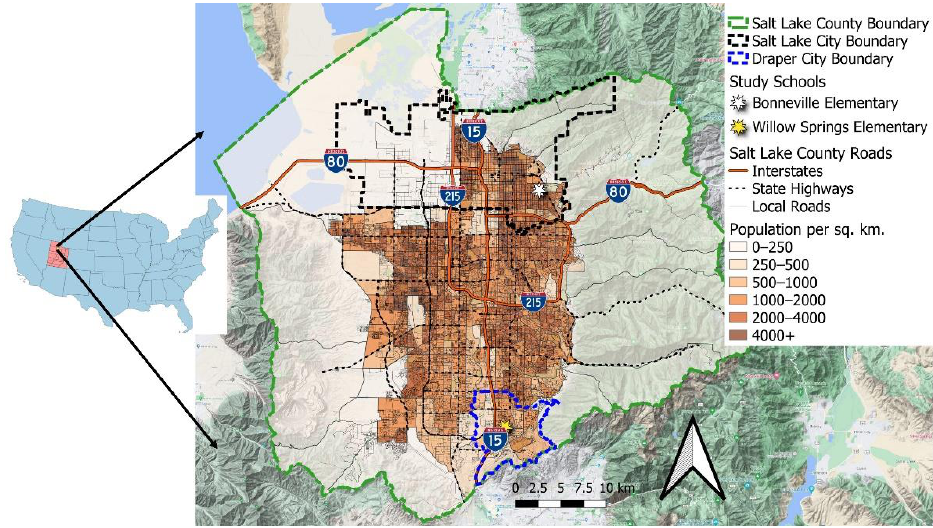
Figure 1. Salt Lake City and Salt Lake County within Utah and the United States (left inset) with the interstate highways (I-15, I-80, I-215) noted.